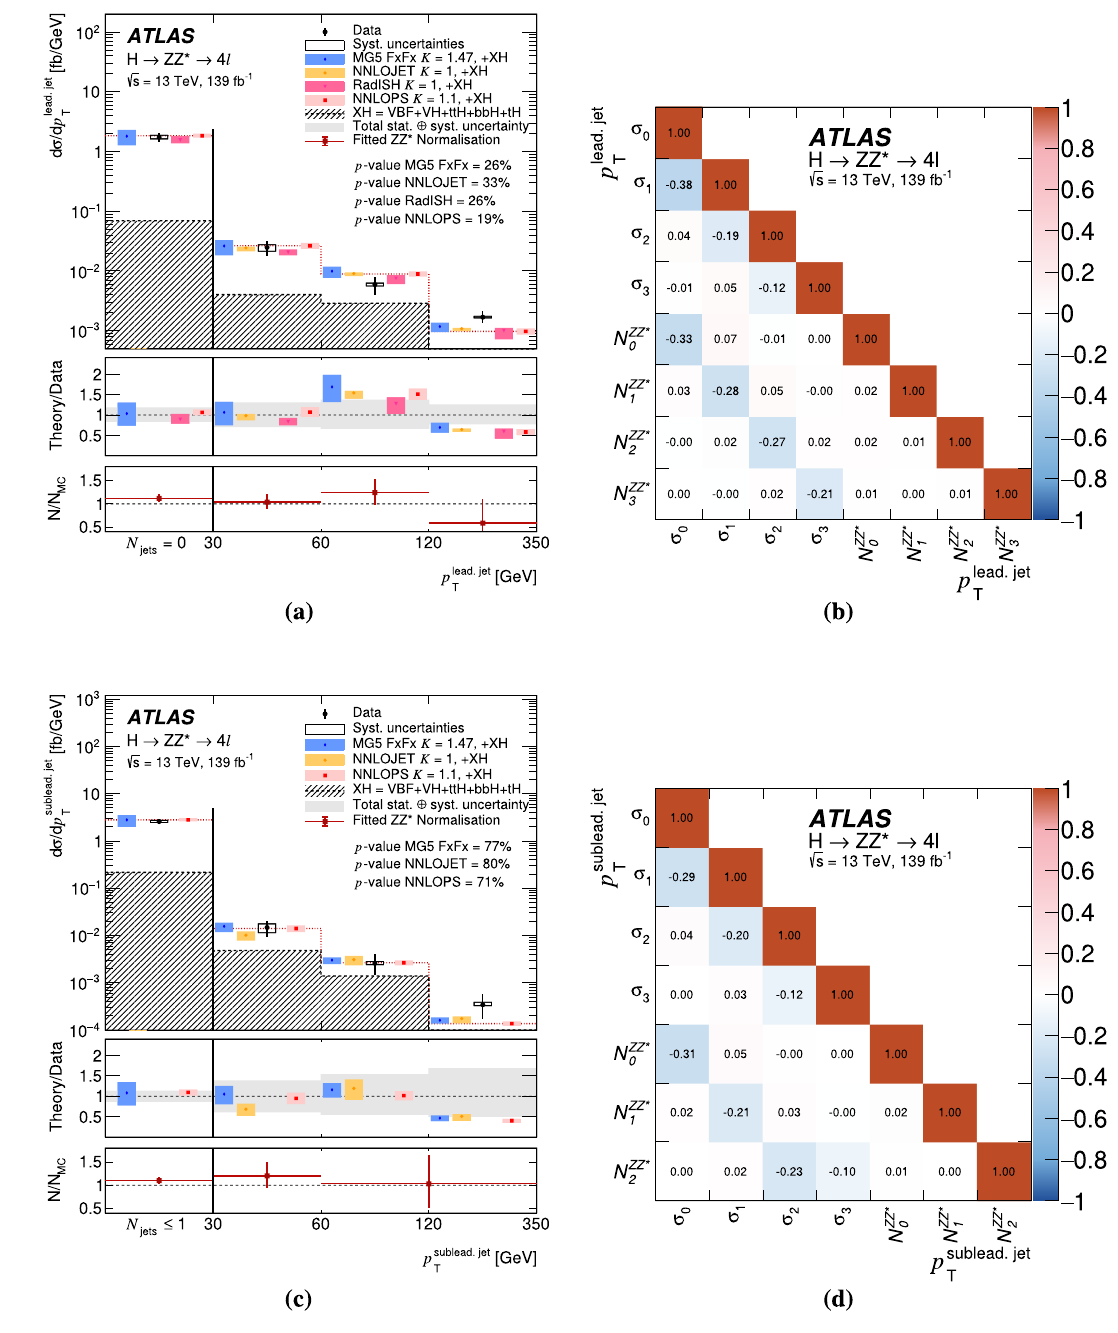
Fig. 26 Differentialfiducialcrosssectionsfor a thetransversemomen- the highest and second-highest transverse momenta. The first bin con- . jet tains events which do not pass the jet requirements. The corresponding tum of the leading jet, p lead , in events with at least one jet, and c T . jet correlation matrices between the measured cross sections and the Z Z ∗ the transverse momentum of the subleading jet, p sublead , in events T background normalisation factors are also shown ( b and d with at least two jets. Leading and subleading jets refer to the jets with